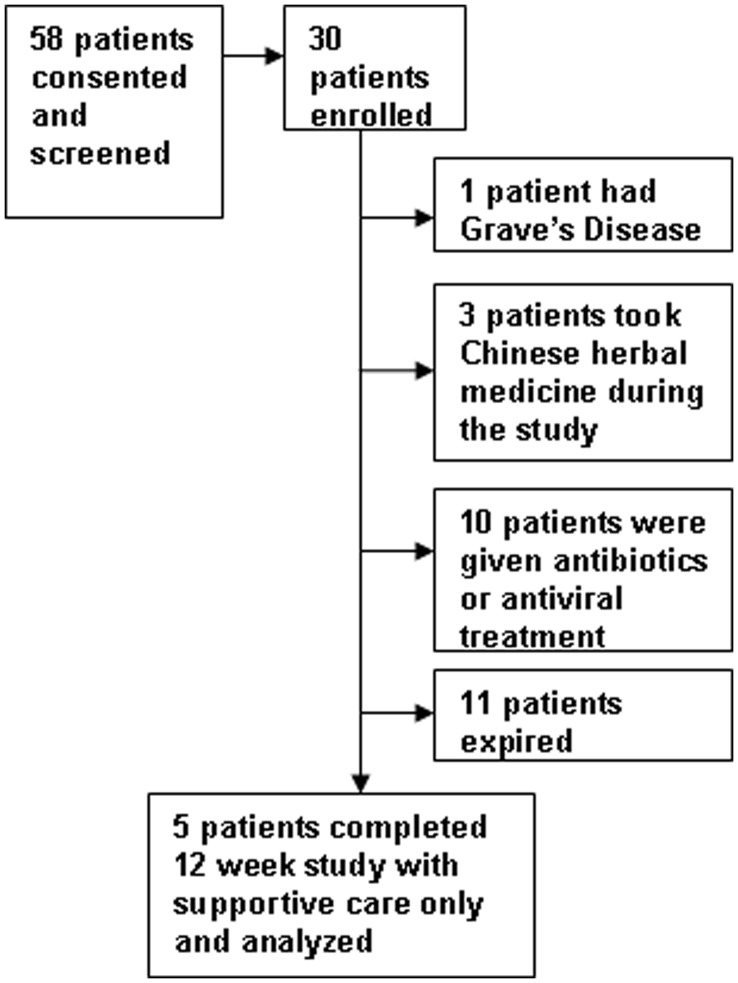
Patient selection and deposition.